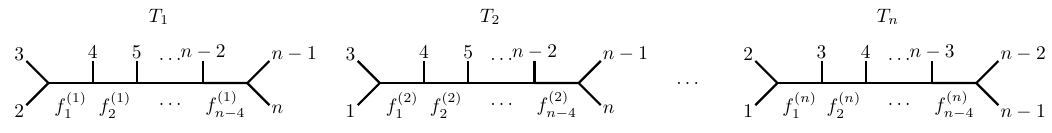
Figure 4 . Planar collection obtained from the caterpillar tree with n leaves in figure